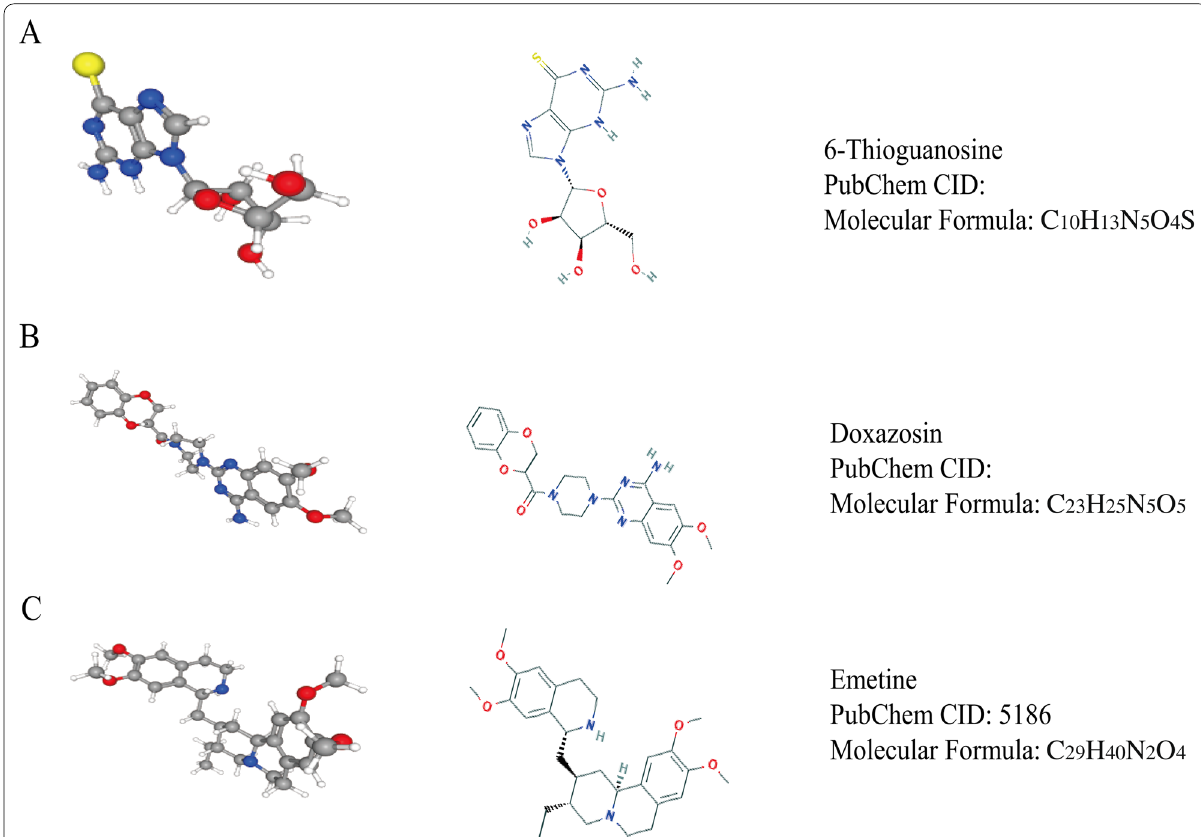
Fig. 9 2D and 3D structures of anti-glioma micromolecule drugs targeting GINS4 . A 6-Thioguanosine; B doxazosin; C